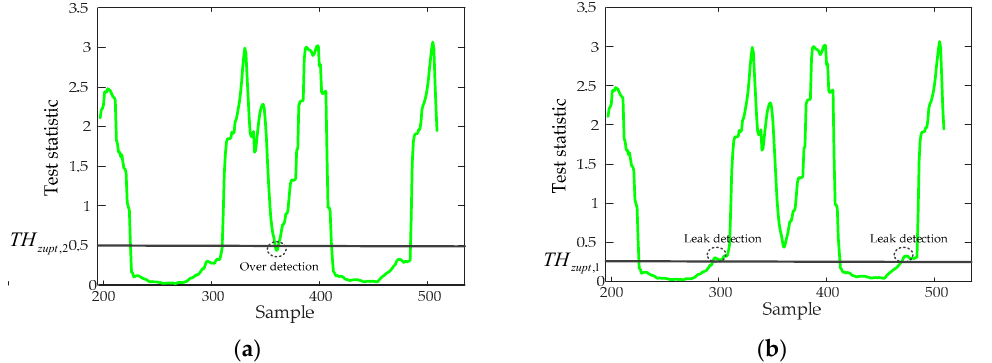
Figure 3. The detection results of still-phase based on the pre-defined threshold method. ( a ) The detection result using a larger threshold; ( b ) the detection result using a smaller threshold.